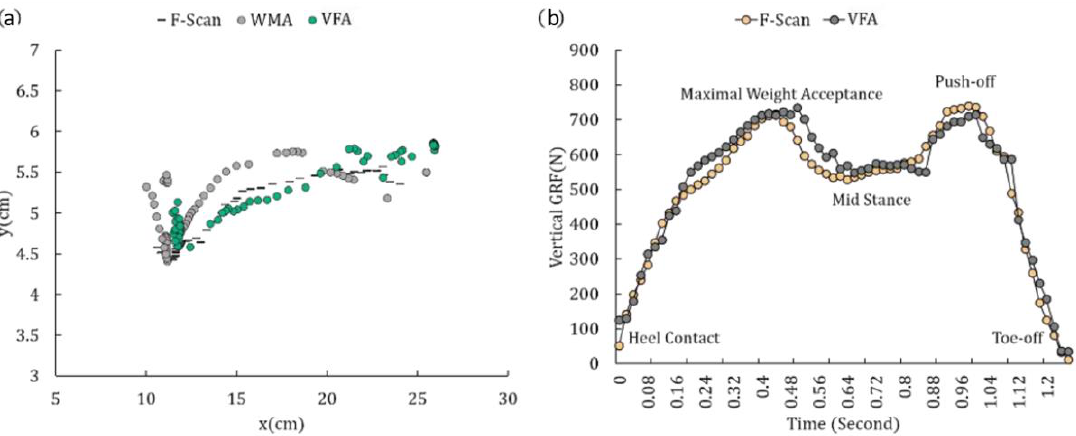
Figure 7. ( a ) One chosen CoP trajectory plot during the stance phase of the 1 km/h gait cycle experiment by the WMA, VFA and F-Scan. ( b ) One chosen GRF trajectory plot during the stance phase of the 1 km/h gait cycle experiment by the VFA and F-Scan. Table 2 show the RMSE and correlation coefficients calculated by the VFA and the WMA with the reference data of the F-Scan system. For the GRF, the average RMSE during all the experiments is 29.34 N. There is a value of 8.29 mm for CoP calibration by the VFA and 16.89 mm by the WMA. The average correlation coefficients are 0.94 for the GRF estimation, 0.94 for the X coordinate of the CoP by the VFA, 0.76 for the Y coordinate of the CoP by the VFA, 0.89 for the X coordinate of the CoP by the WMA, and 0.64 for the Y coordinate of the CoP by the WMA. Figure 8 shows the RMSE of the VFA and the WMA by the reference data of all the subjects during each experiment. The green bars of the WMA have higher values than the yellow bars of the VFA, so it is clear that the error decreased with the proposed